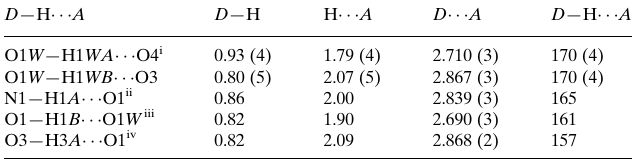
Oxford Diffraction Gemini-S Ultra sapphire CCD diffractometer Absorption correction: multi-scan ( CrysAlis PRO ; Agilent, 2011)